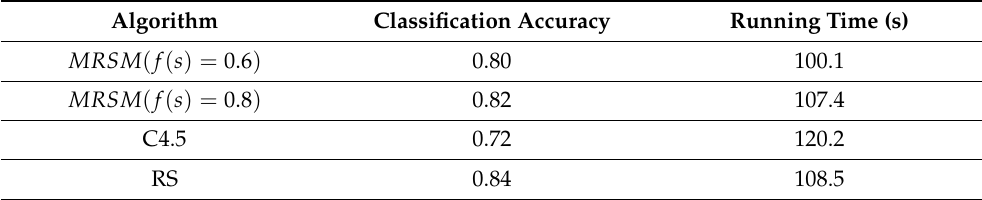
Table 3. Comparison of the decision tree performances of the different algorithms. Algorithm Classification Accuracy Running Time